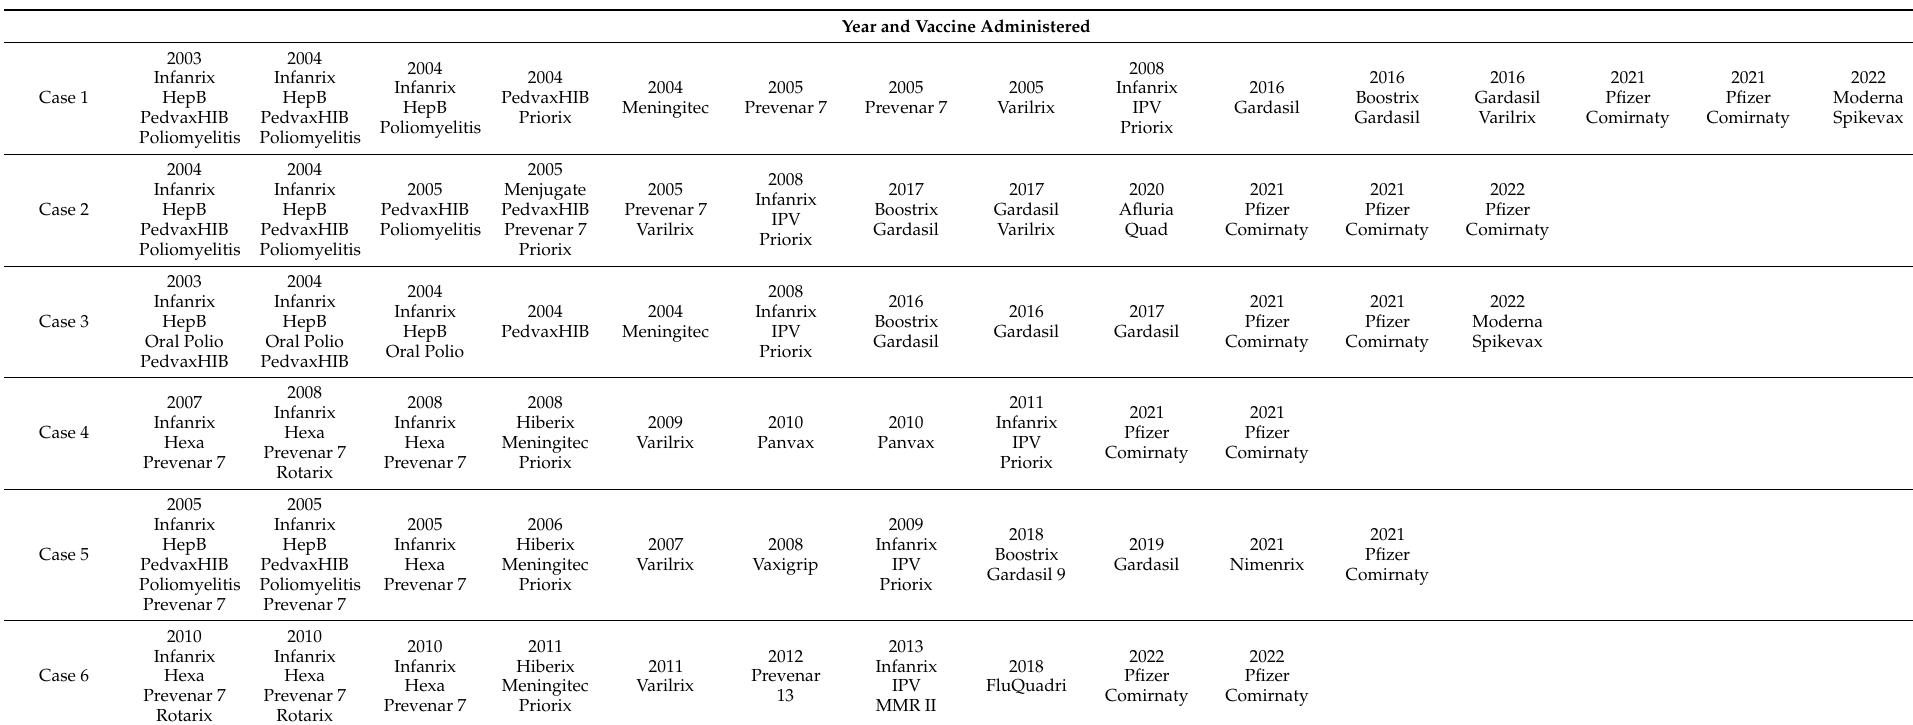
Table 3. Vaccination history for cases